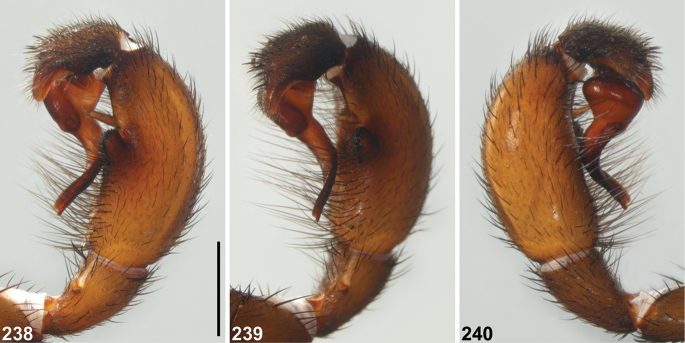

Idiosoma
jarrah sp. n., male holotype (WAM T124143) from Lesmurdie (Western Australia; JAF), pedipalp. 238 Retrolateral view 239 Retroventral view 240 Prolateral view. Note that the tip of the embolus has broken off this specimen. Scale bar 2.0.